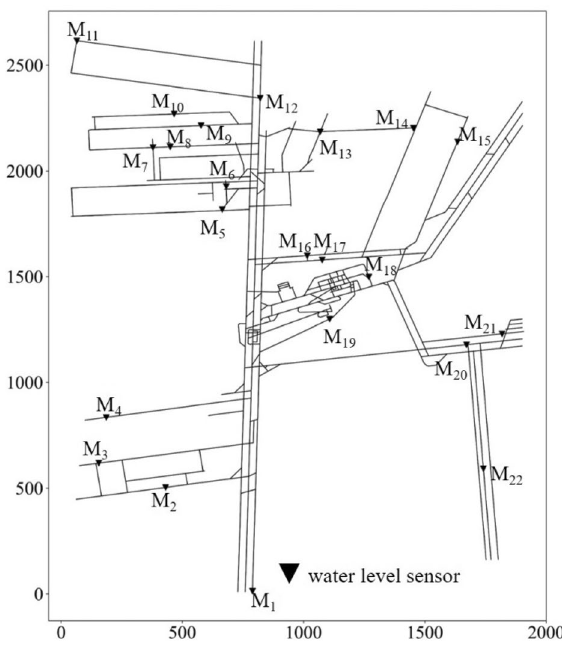
Figure 10. Optimal location result of water level sensors in Beiyangzhuang